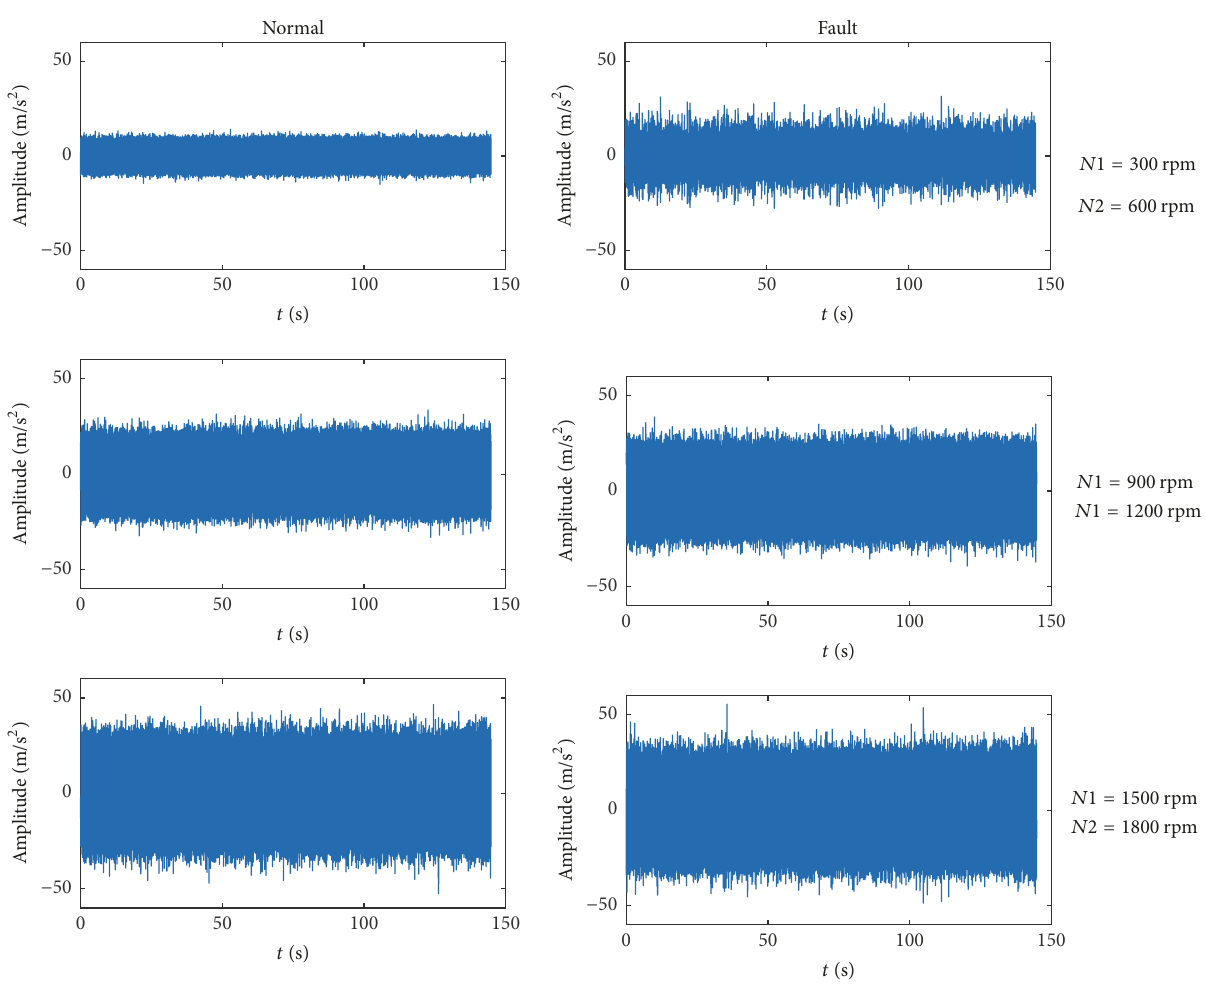
Figure 7: Waveforms of normal and fault vibration signals.